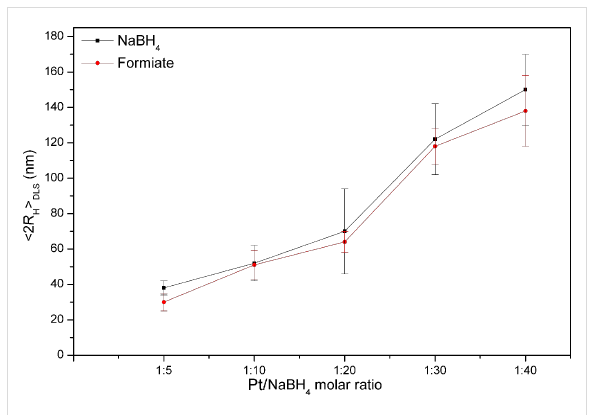
Figure 3: 3 Influence of Pt/reducing agent molar ration in the forma- tion of Pt-DEA nanoparticles: DLS results in